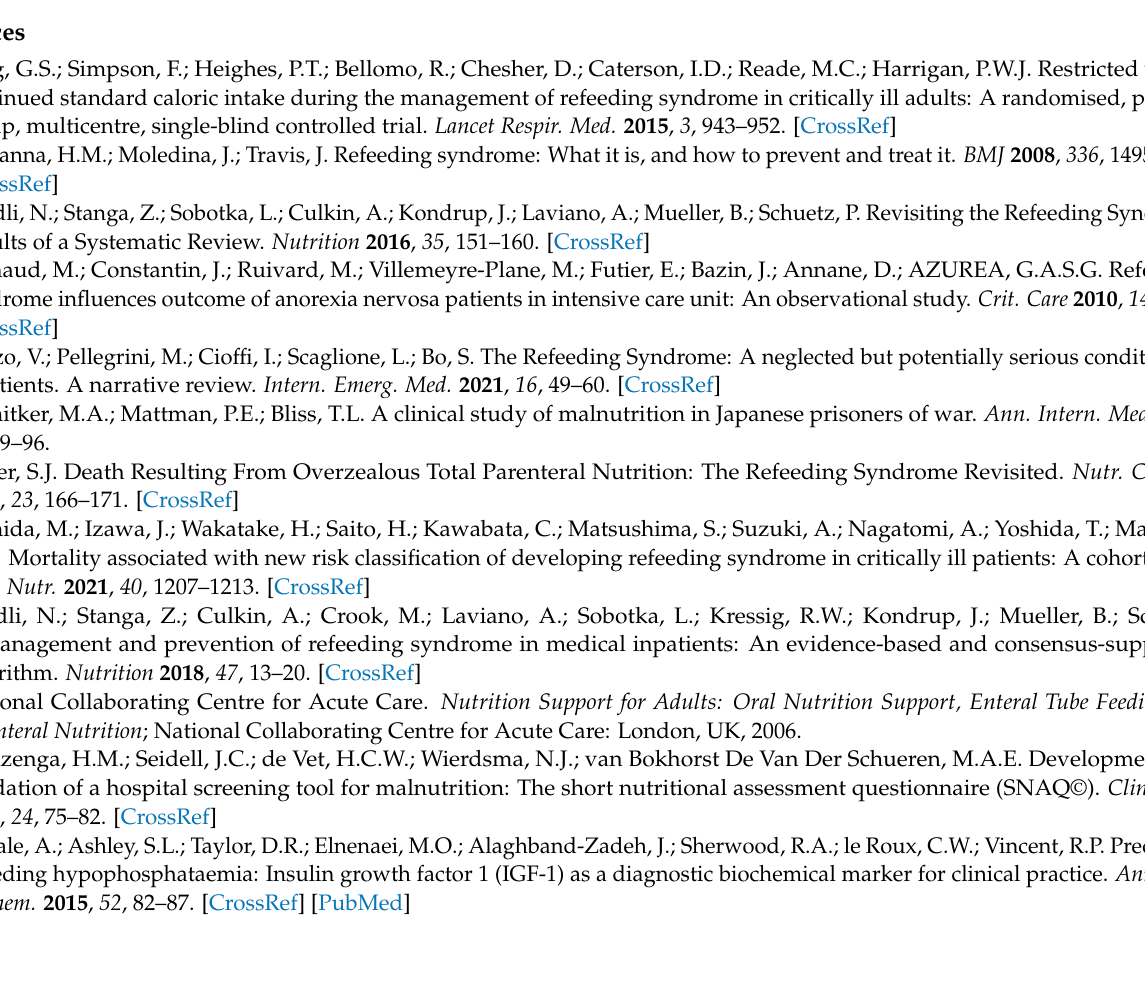
mASPEN. Figure S2. Receiver operating characteristic (ROC) curve analysis of ASPEN, mASPEN1, mASPEN2, and mASPEN scores for prediction of